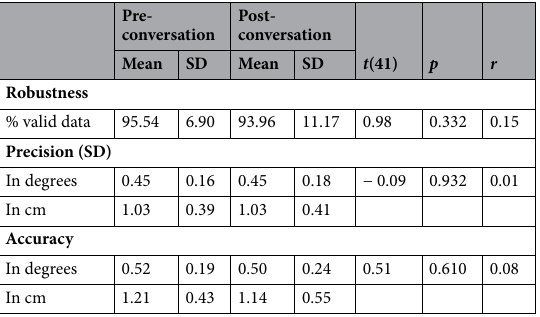
Table 3. Robustness, precision and accuracy during the validation sequence before and after the face-to-face conversation. Quality indices were averaged for gaze data on left and right eyes, nose, and mouth. Precision (SD) = standard deviation of data samples (Holmqvist et al., 2011).